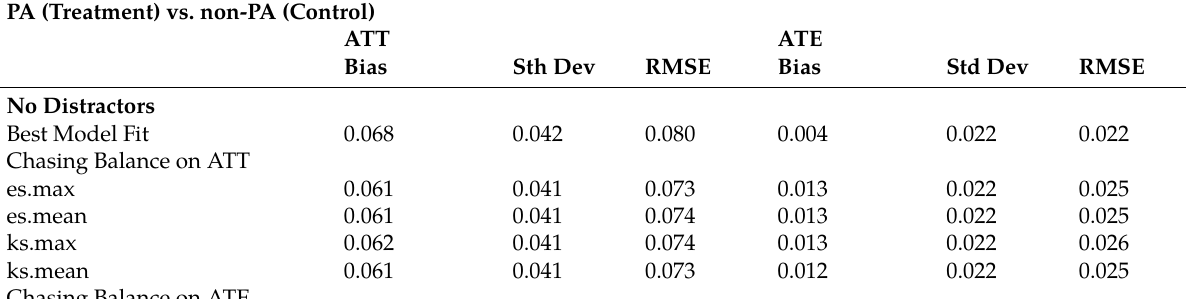
Table 6: Summary Statistics for Treatment Effect Estimates for all stopping rules and methods considered for the PA